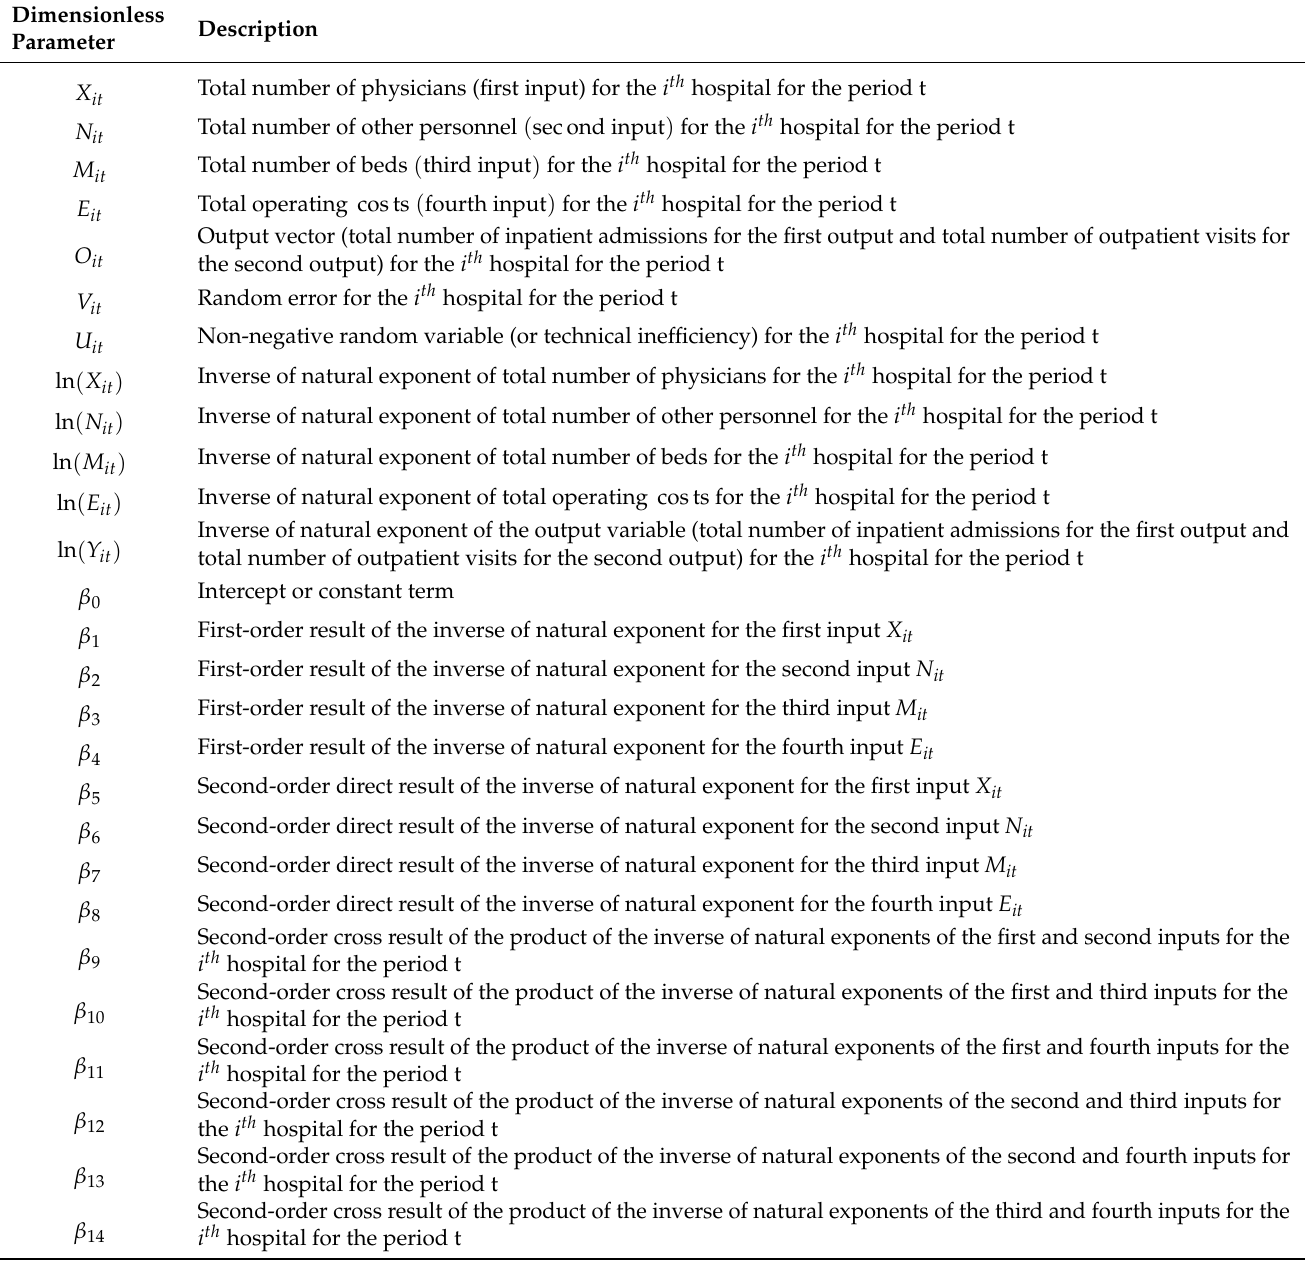
Table 4. Explanation of the parameters for primal and dual SFA